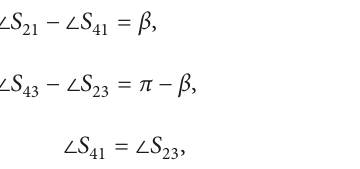
Figure 1: Butler matrix topology.